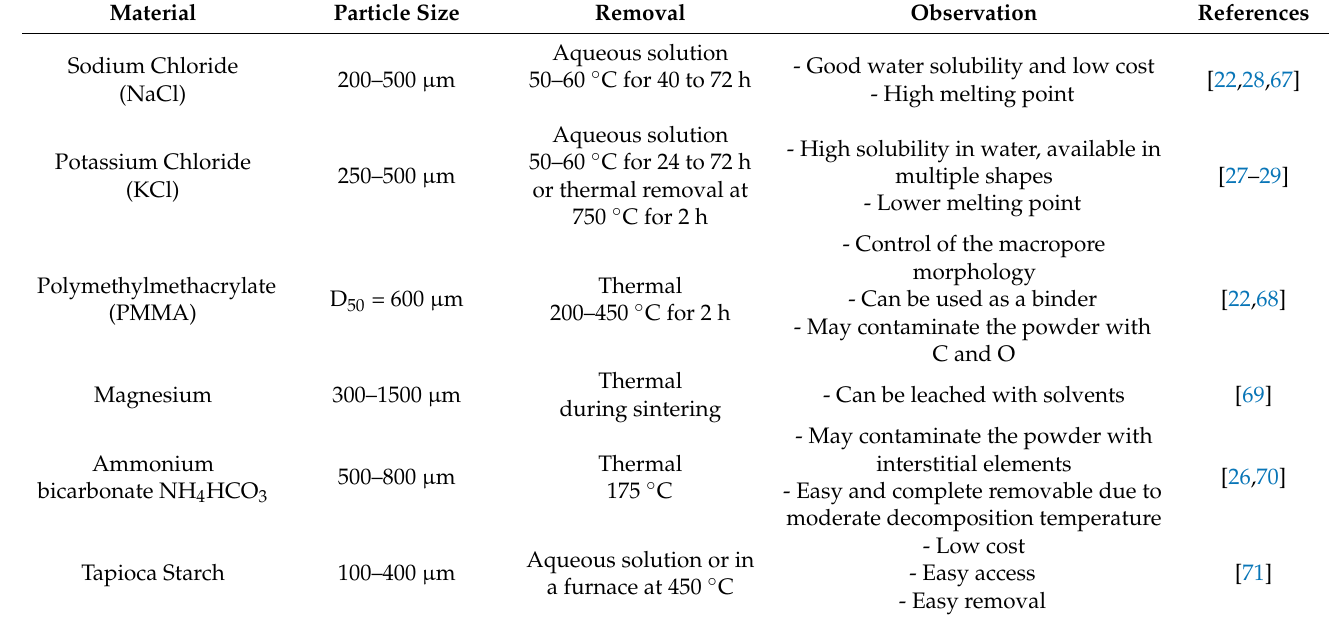
Table 2. Typical space holders used in the literature and their morphological and removal